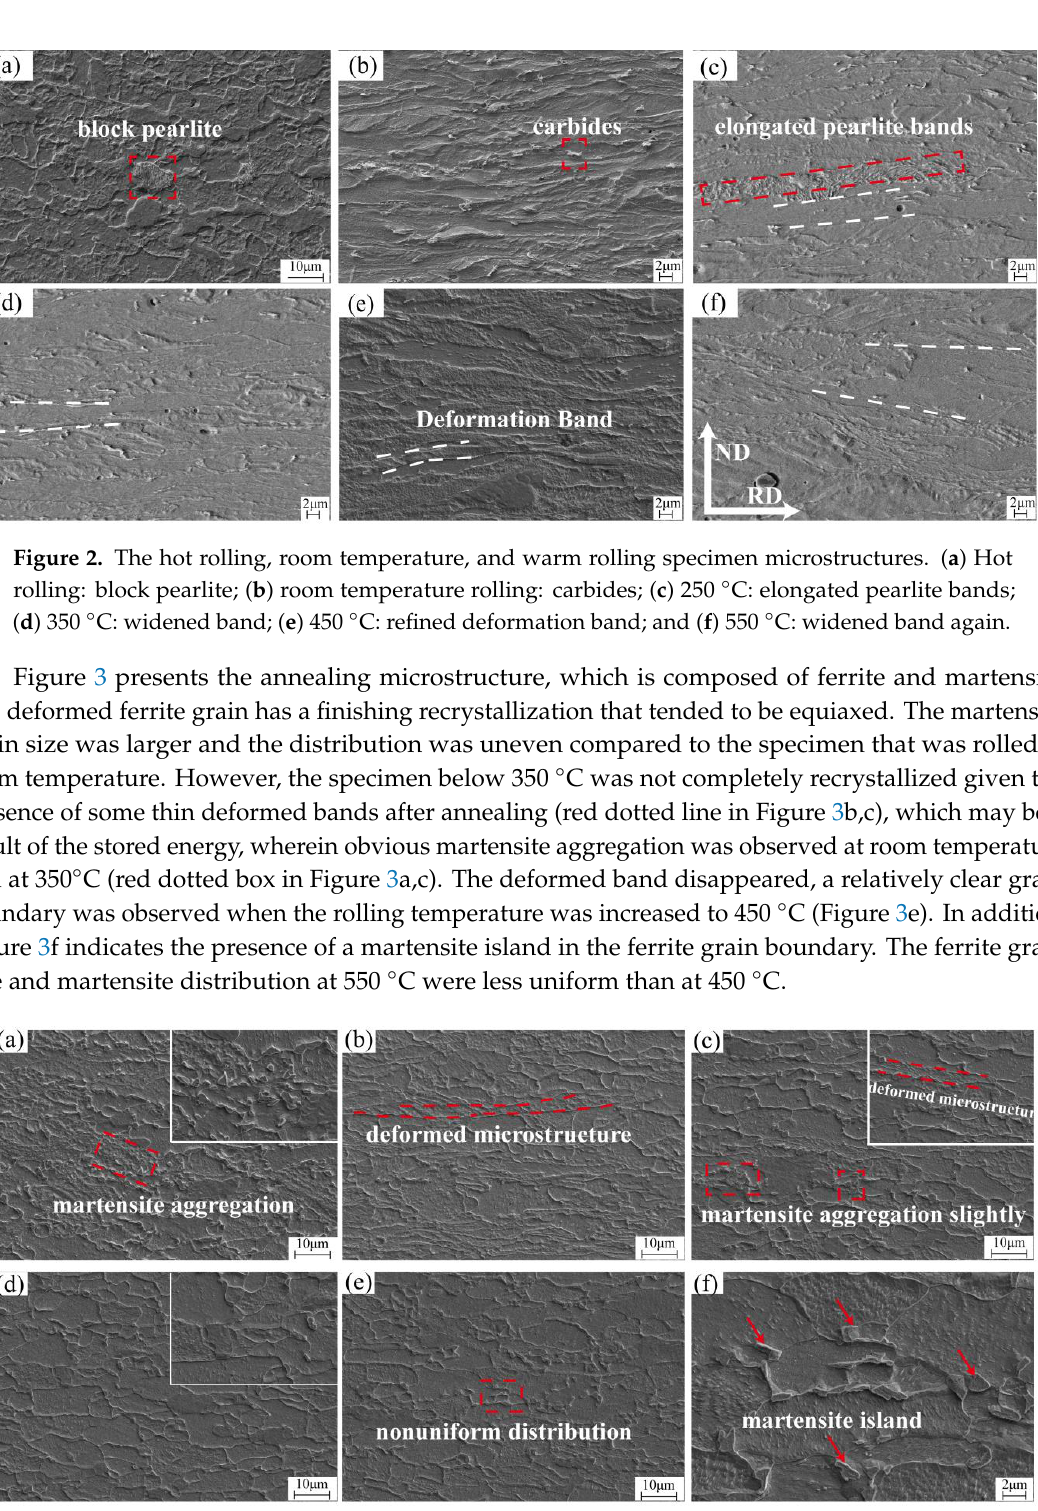
Figure 3. SEM microstructure after annealing. ( a ) Room Temperature: martensite aggregation; ( b ) 250 °C: vestigial bands; ( c ) 350 °C: slight martensite aggregation; ( d ) 450 °C: uniform distribution; and ( e , f ) 550 °C.